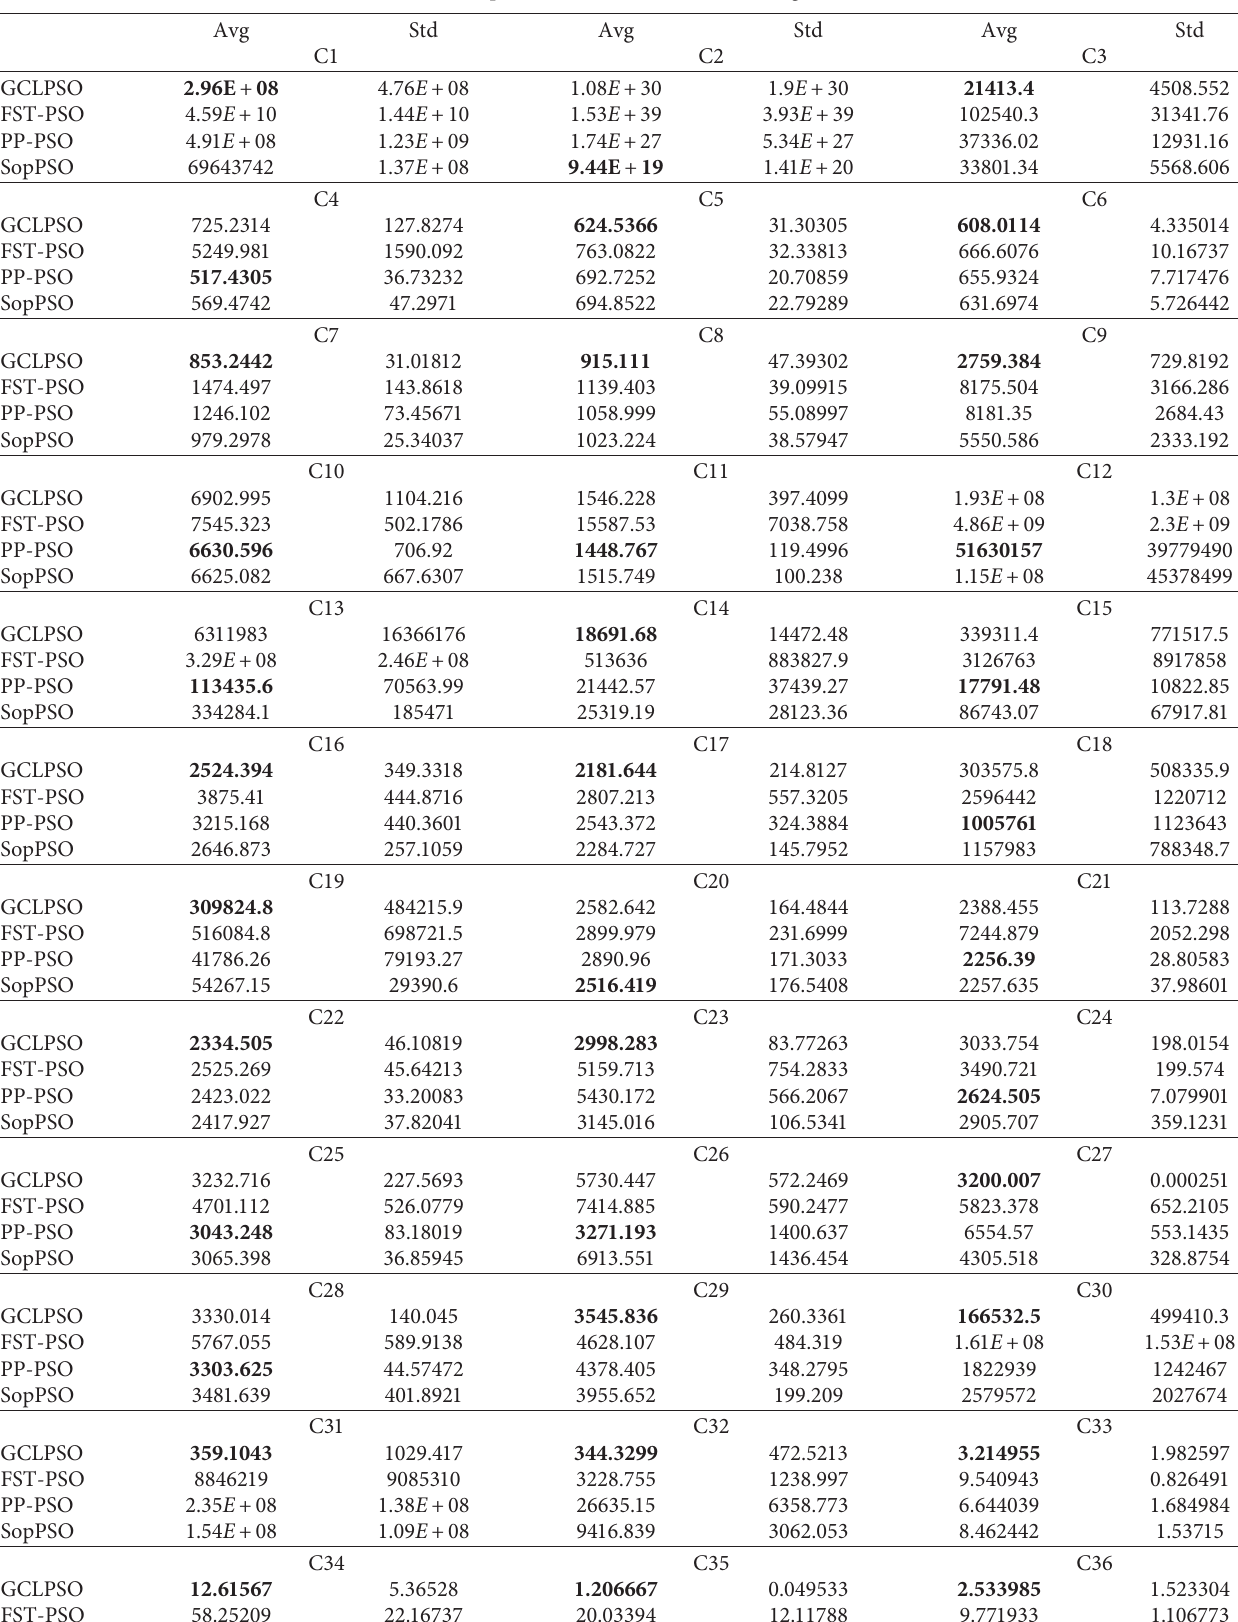
Table 5: Comparison of results for different